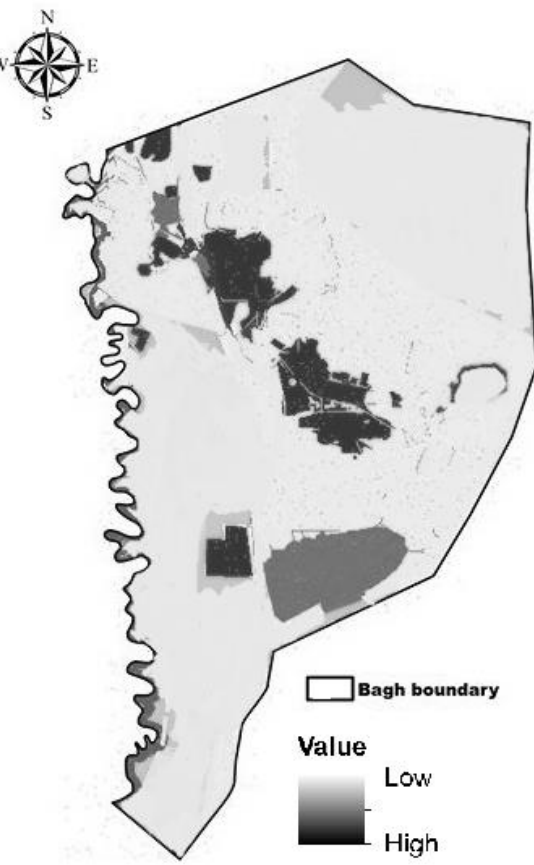
Figure 5. Urbanization prediction map of Darkhan